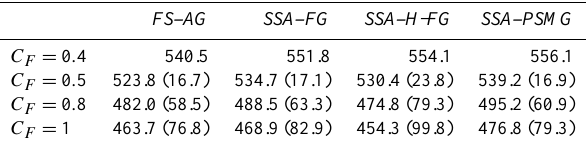
Table 2. Parameters of initial steady state. Table 3. GL position for the intial steady state ( C F = 0 . 4) and for the different perturbations for each model after 200yr. The differ- ence between the initial steady state and the perturbed state is given in brackets. All values are in